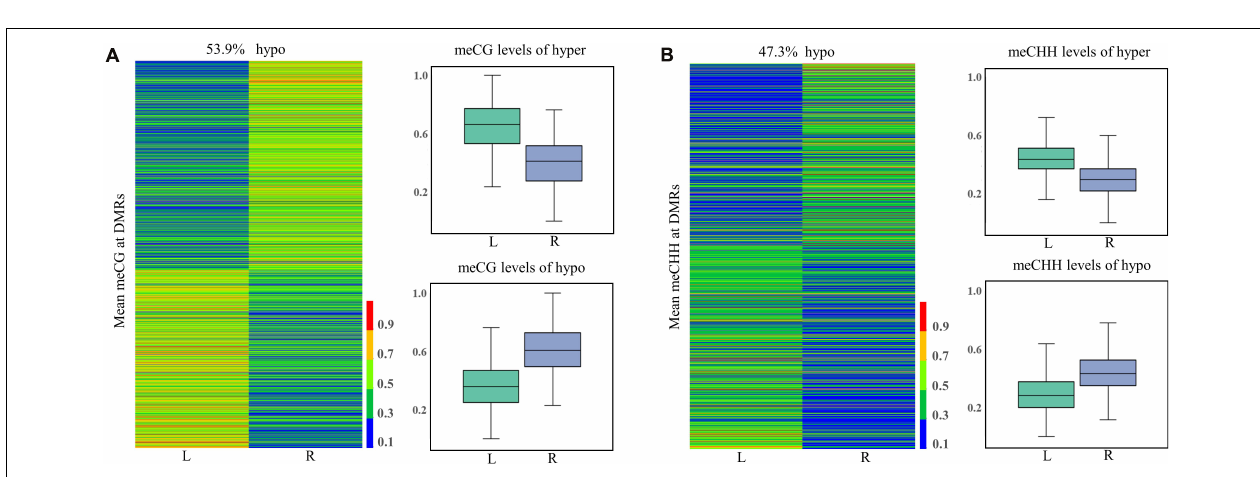
FIGURE 3 | Number of differentially methylated regions (DMRs) in different genomic elements among the left-side (affected-side; L) and the right-side (normal-side; R) mandibular condyle of crossed beak chicks with left mandibular curvature.